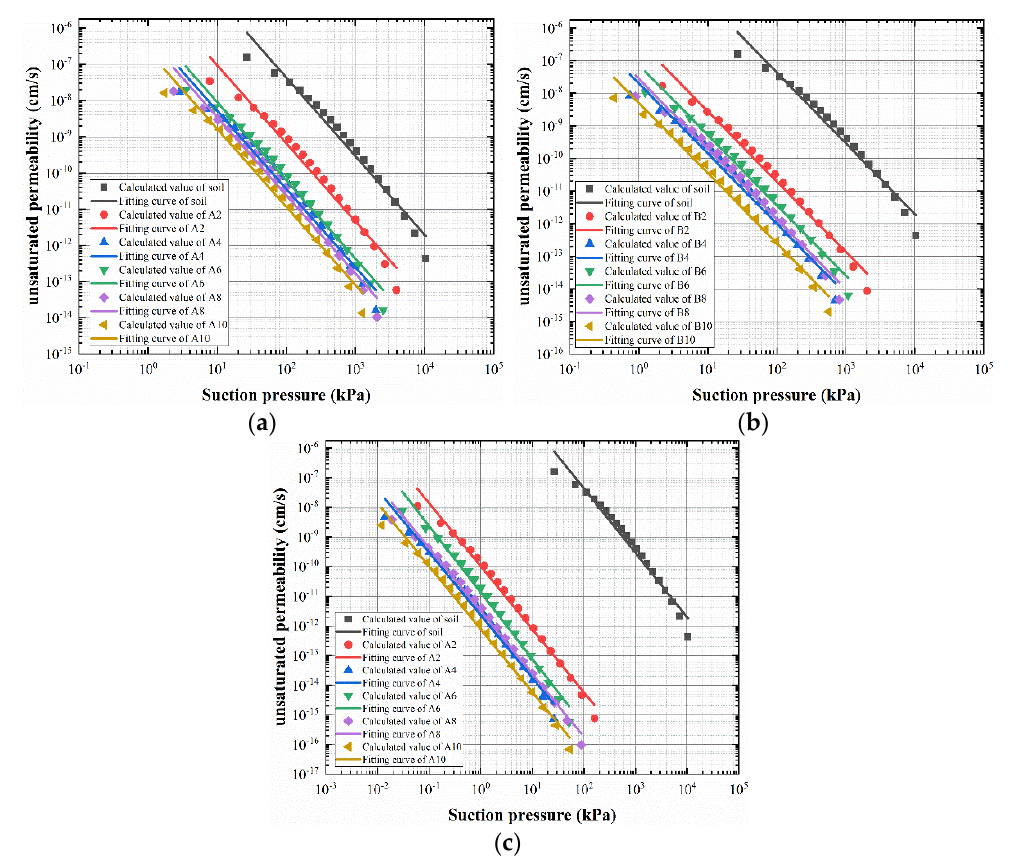
Figure 15. Fitting curves of unsaturated permeability coefficients of soils after different hydrophobic treatments: ( a ) the permeability coefficients and fitting curves of SMS-A under different times; ( b ) the permeability coefficients and fitting curves of SMS-B under different times; ( c ) the permeability coefficients and fitting curves of SMS-C under different times.